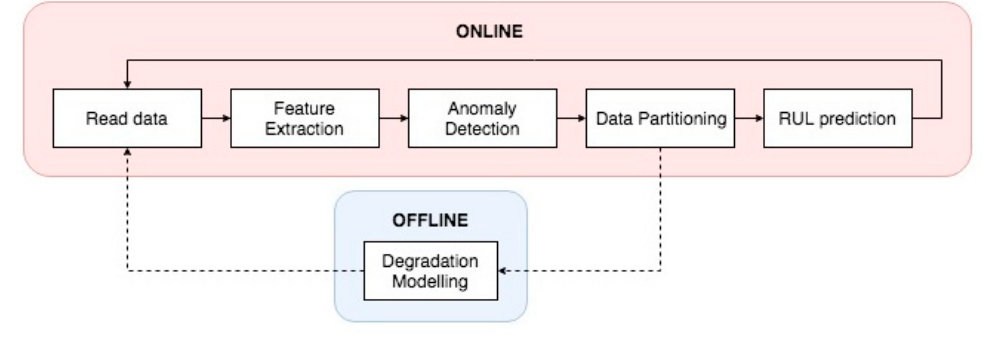
Figure 1. The proposed methodology.